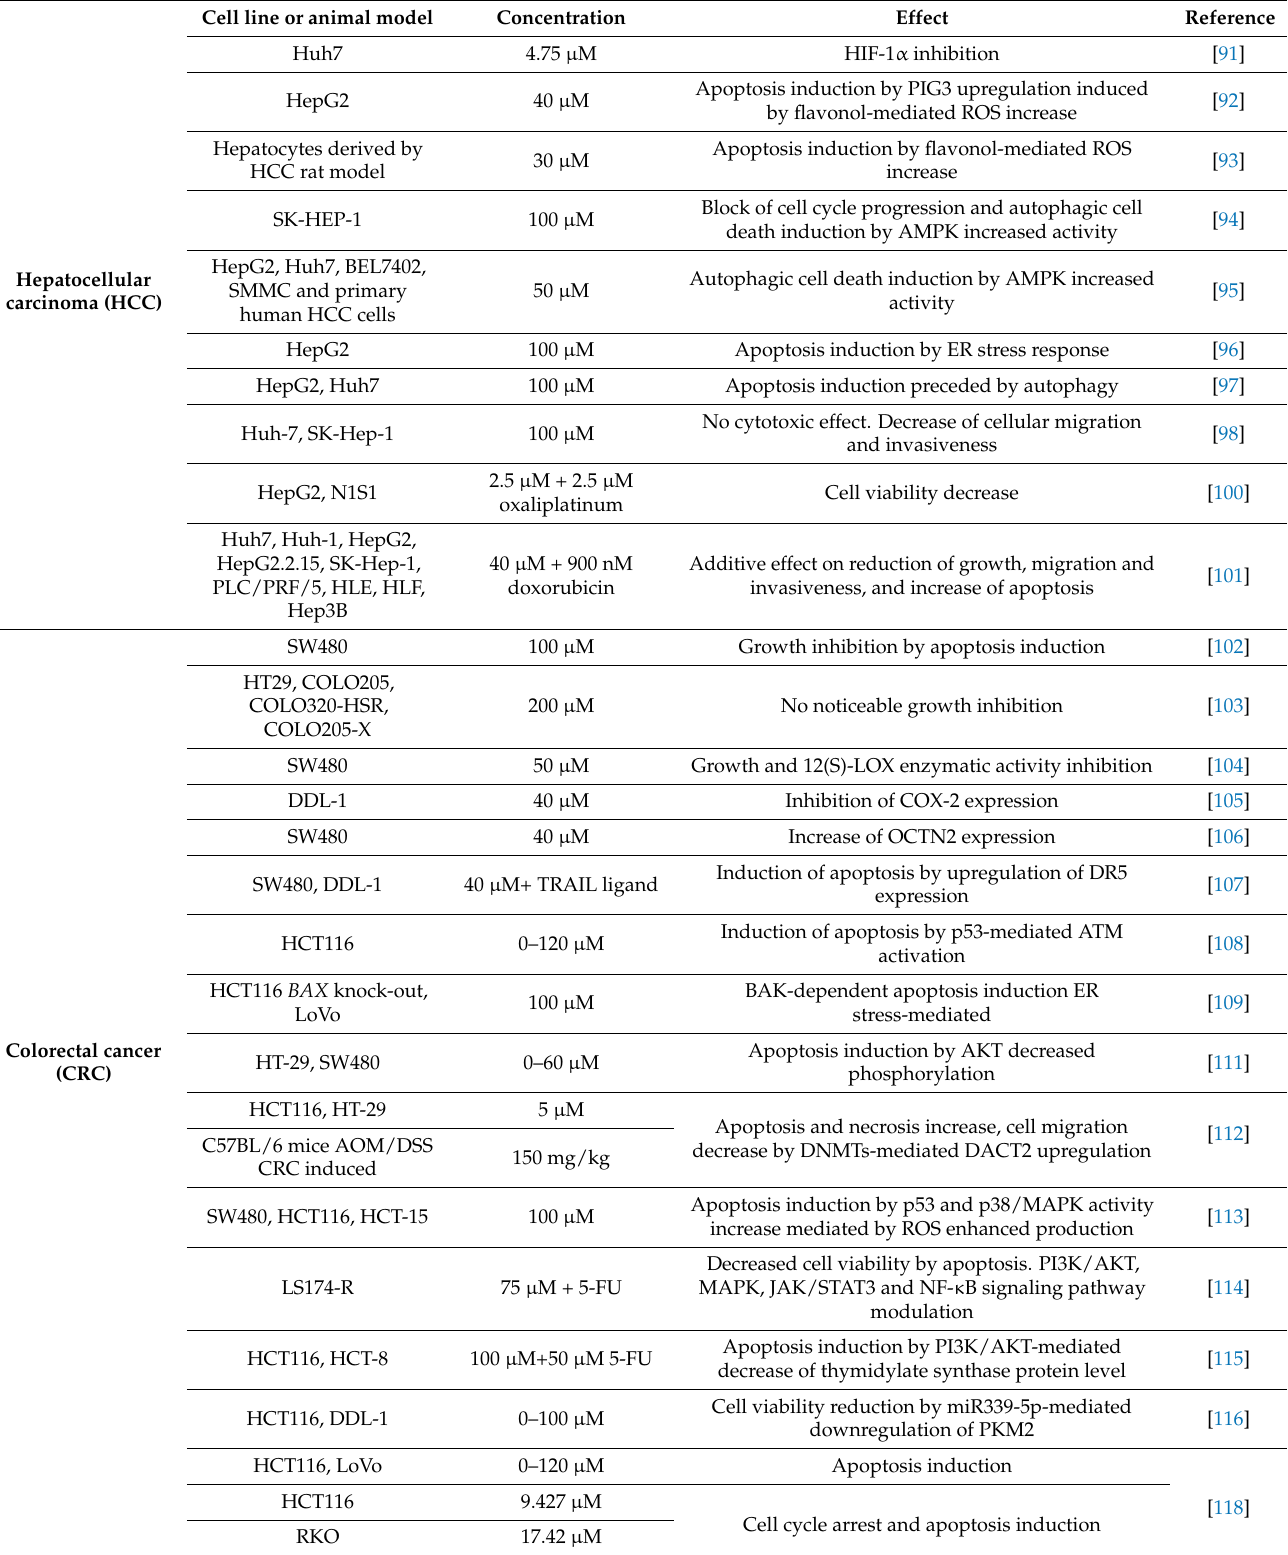
Table 2. Anti-cancer effects of kaempferol in different in vitro and in vivo experimental models.